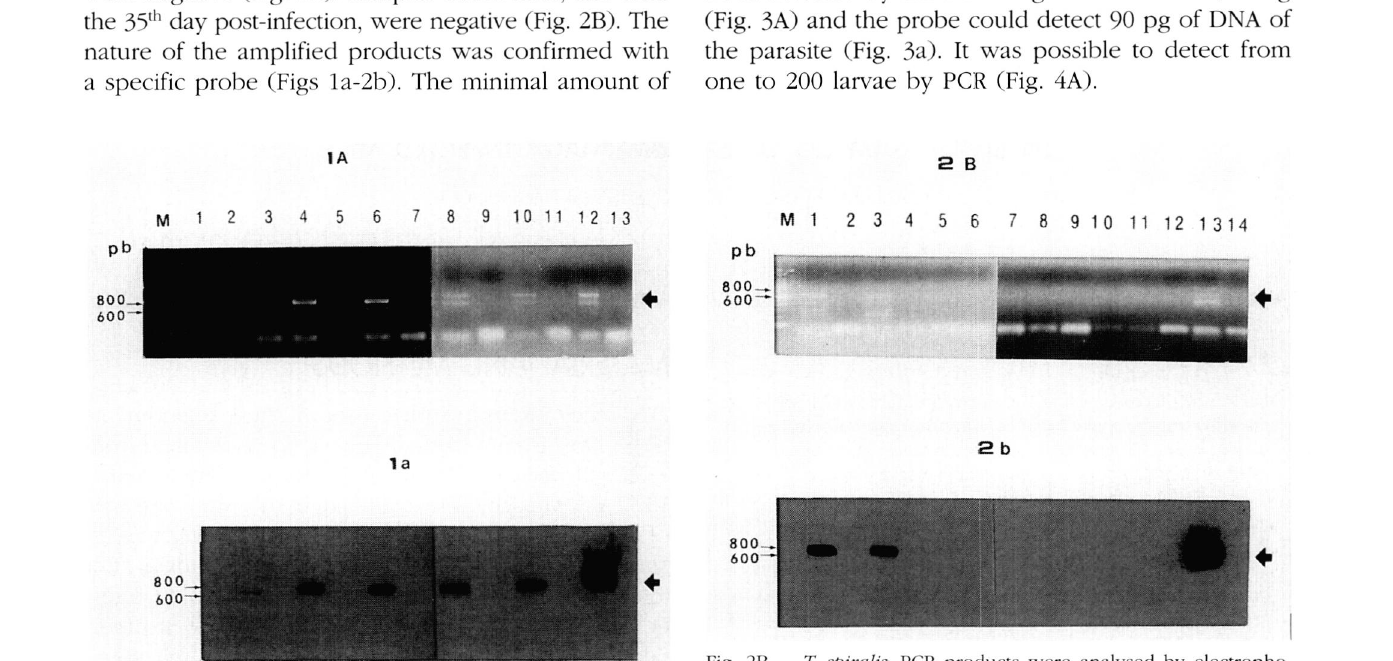
Fig. 2B. - T spiralis: PCR products were analysed by electropho resis in 1.5 % agarose gel, days (15-35). M: Molecular weight. Line